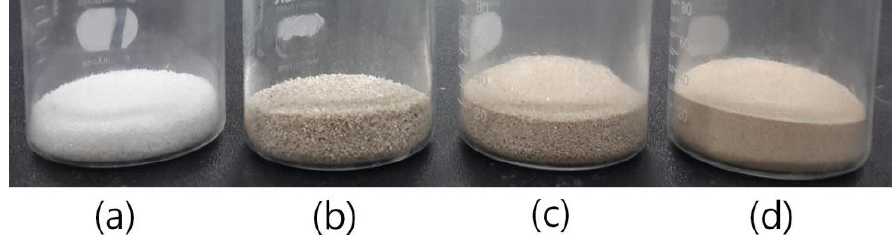
Figure 2. Sand samples artificially contaminated with uranium. ( a ) Sea sand; ( b ) coarse soil sand; ( c ) medium soil sand; and ( d ) fine soil